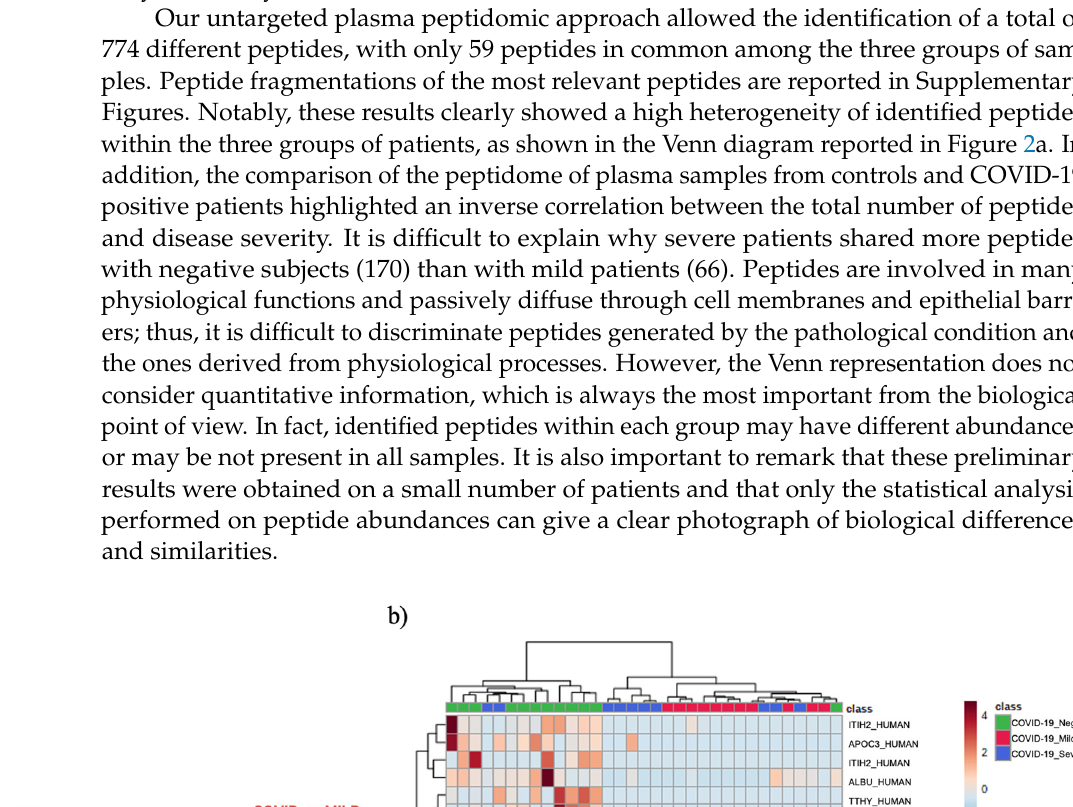
presence of 73 modulated peptides in COVID-19 patients compared to negative